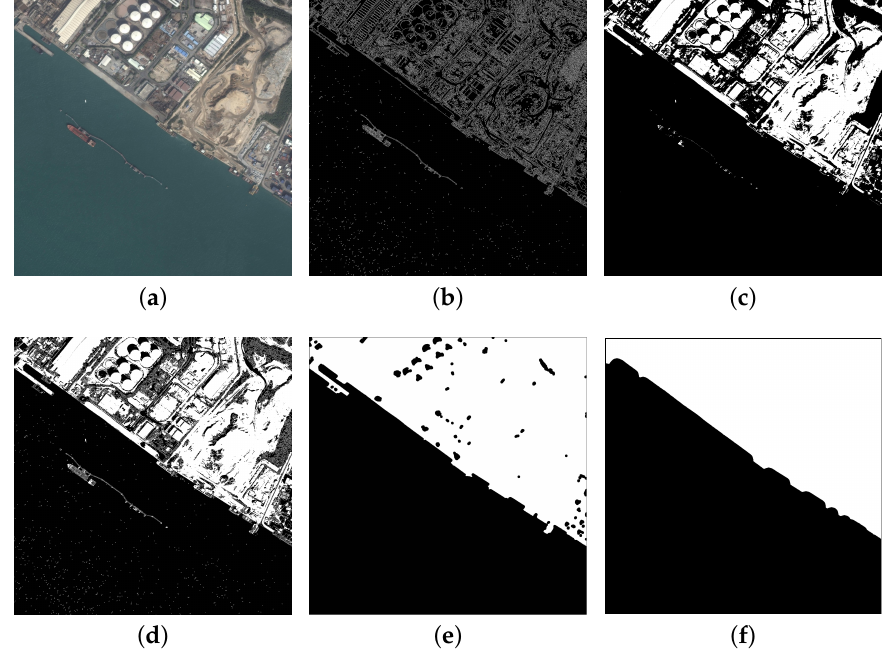
Figure 4. The intermediate results of one typical image slice in the sea-land separation process. The intermediate results of one typical image slice in the sea–land separation process. ( a ) The original image. ( b ) The edge detection result of the original image. ( c ) The threshold segmentation result of the original image. ( d ) The result after logical OR operation. ( e ) The result after preliminary morphological filtering. ( f ) The final sea–land separation result of the testing